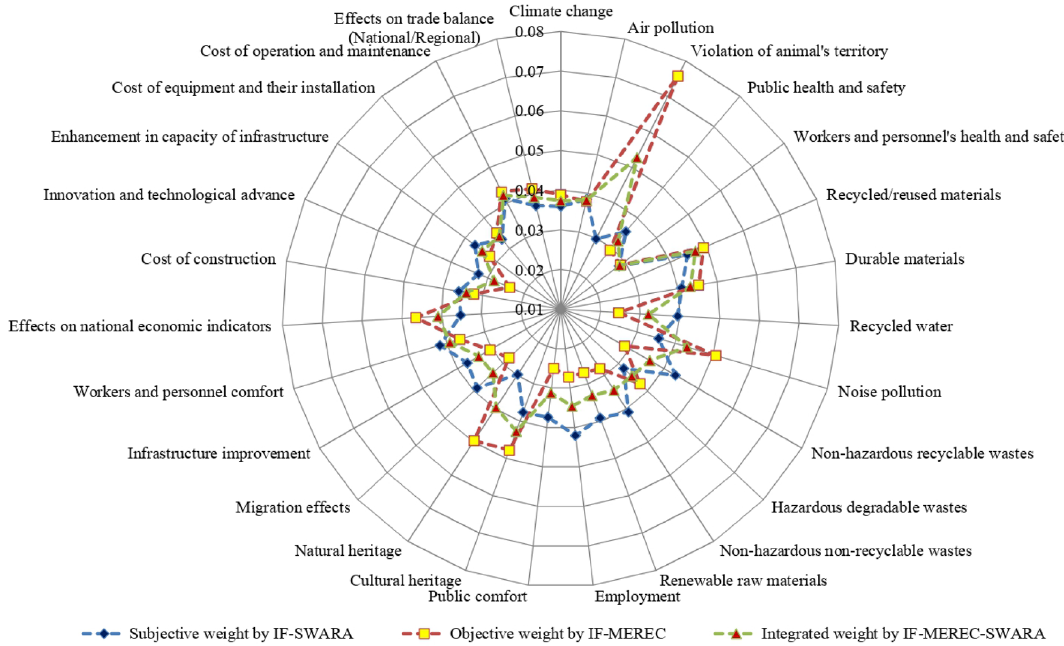
Figure 5. Preference order of SDIs using IF-MEREC-SWARA method.